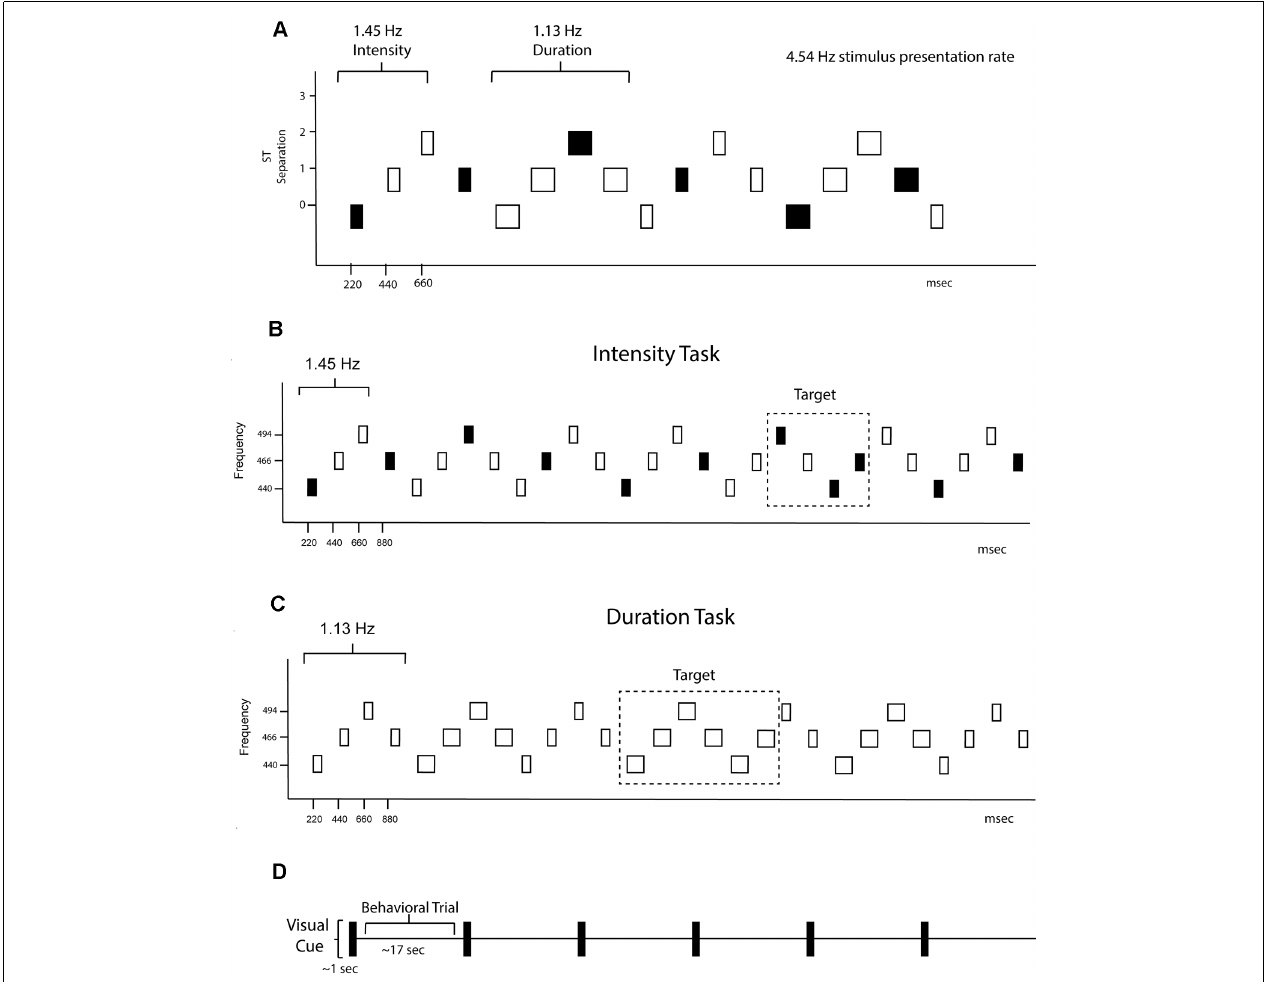
FIGURE 1 | Experimental protocol. (A) Schematic of the overall stimulus paradigm. The X-axis shows the timing in milliseconds and the Y-axis shows the frequency separation in semitones (ST). The rectangles represent the tones. The fill represents intensity, with black representing louder intensity tones and the white softer intensity tones, and the width of the rectangle represents tone duration. Both intensity and duration patterns were presented randomly within the stimulus blocks and are demarcated with the rhythm of each denoted. The global rhythm of the tones in the sequence was 4.54 Hz. (B) Intensity task. Only the intensity rhythm is displayed. The standard 4-tone intensity pattern was loud-soft-soft-loud, and had a rhythm of 1.51 Hz. The task was to keep the standard pattern in mind and press the response key when the pattern deviant (loud-soft- loud -loud) was detected. Thus, the button press was time-locked to the 3rd tone of the pattern where a louder tone came when a softer tone was expected. The frequency of the tones is displayed on the y-axis. The tone duration changes were irrelevant to the intensity task. (C) Duration Task. Only the duration rhythm is displayed. The standard 8-tone duration pattern was short-short-short-short-long-long-long-long, and had a rhythm of 1.13 Hz. The task was to keep the standard pattern in mind and press the response key when the pattern deviant (long-long-long-long- long -long) was detected. Thus, the button press was time-locked to the 5th long tone of the deviant pattern where a shorter tone was expected. The frequency of the tones is displayed on the y-axis. The tone intensity changes were irrelevant during the duration task. (D) Protocol schematic. A visual cue the words “intensity task” or “duration task” (depicted in time as a black rectangle) was presented on the screen for 1 s instructing participants what task to do. Sounds were presented randomly between 15–20 s, comprising one trial. Six trials of “intensity task” or “duration task” were presented randomly throughout each of the 20 blocks.